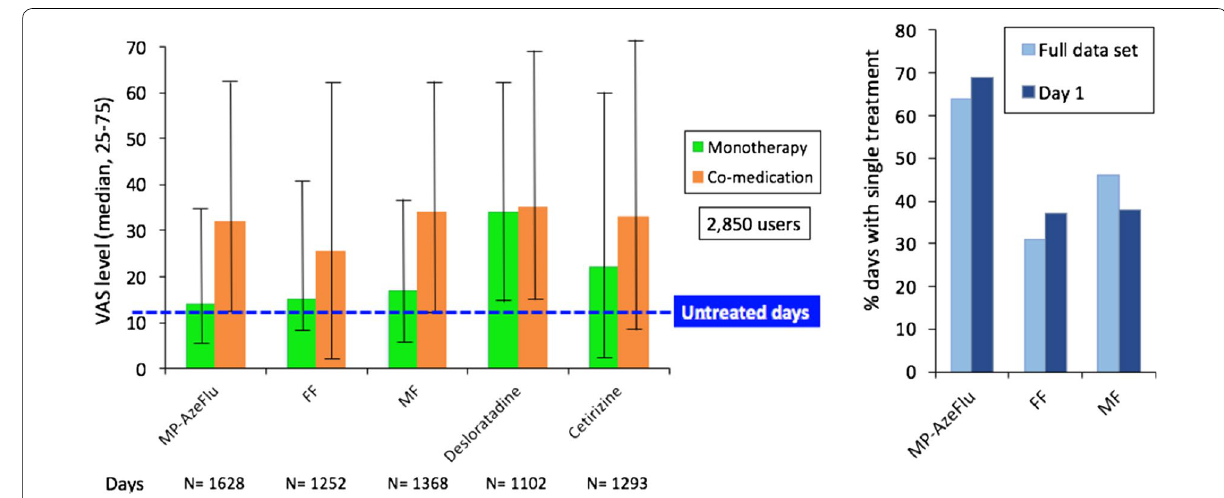
Fig. 10 Treatments received in MAS (from Bousquet et al.